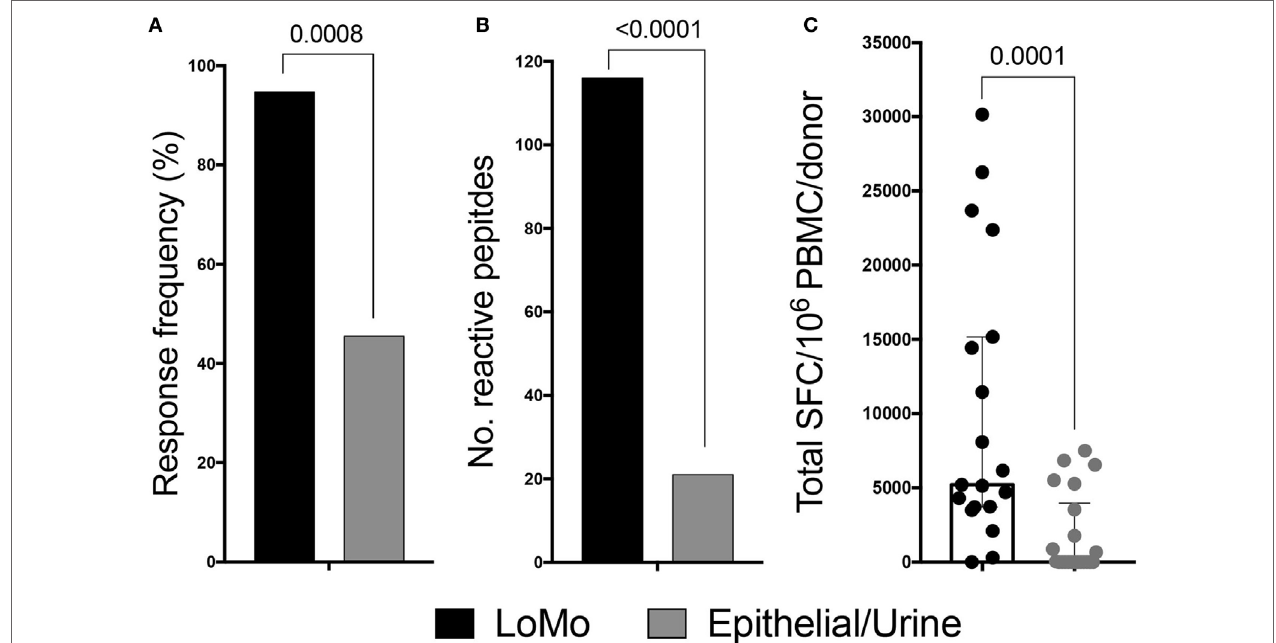
FigUre 2 | LoMo peptides induce antigen-specific responses for T cells derived from mouse allergic donors. Cytokine production was measured by ELISPOT following in vitro restimulation with LoMo peptides or urine/epithelial extract. Donor response frequency (a) and breadth of responses (B) were compared between antigenic stimulation by exact fisher test. (c) Magnitude of responses expressed by spot-forming cells (SFC). Median is shown. Each dot represents combined IL-5 and IFN γ responses of one donor. Statistical analysis was performed by two-tailed Mann–Whitney